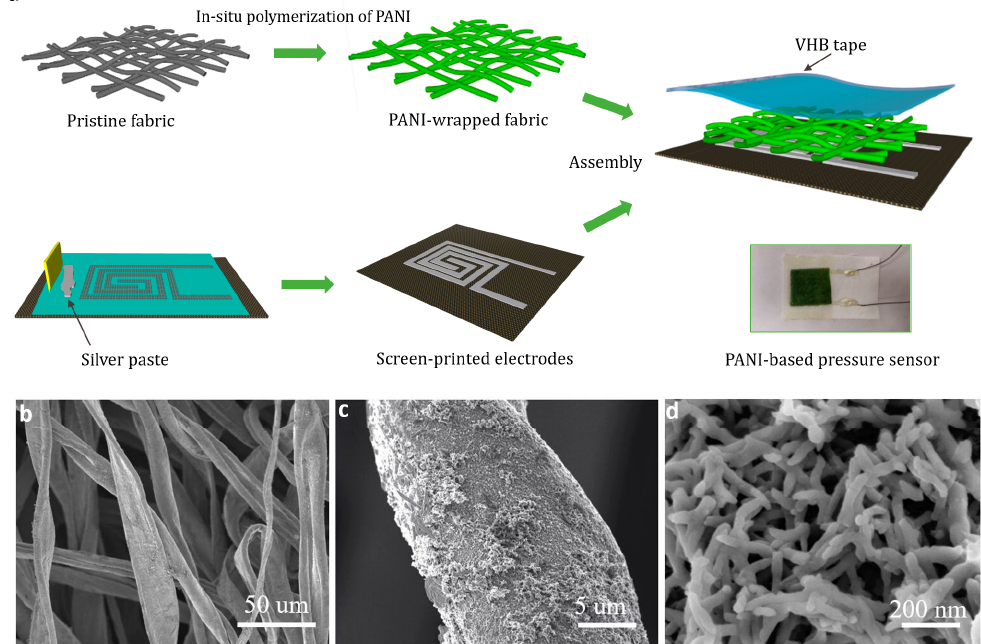
Figure 1. Fabrication process of the polyaniline (PANI)-coated pressure sensor. ( a ) Schematic illustration of the fabrication procedure of the flexible pressure sensor and its digital photograph; ( b – d ) Scanning electron microscopy (SEM) images of the PANI-coated fabric with different magnifications.